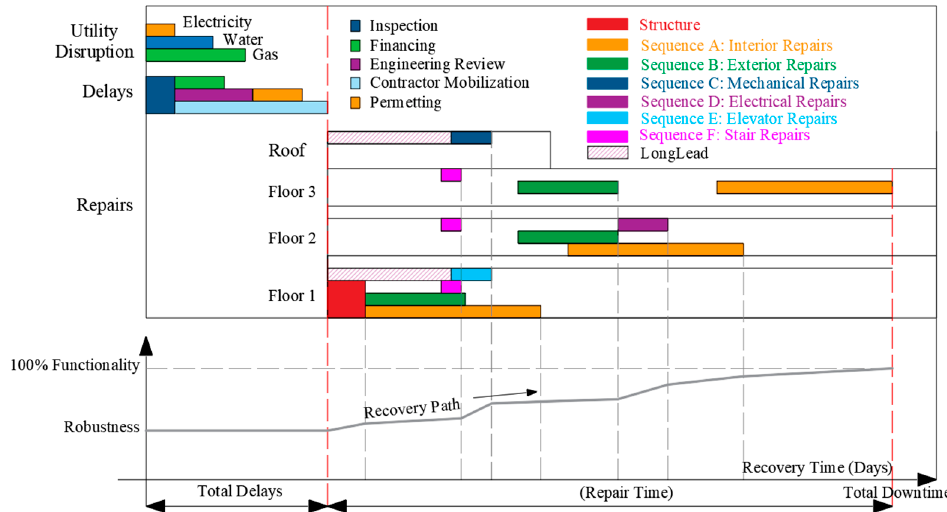
Figure 5. Example of repair sequence, considering delays and utility disruption, adapted from [1].